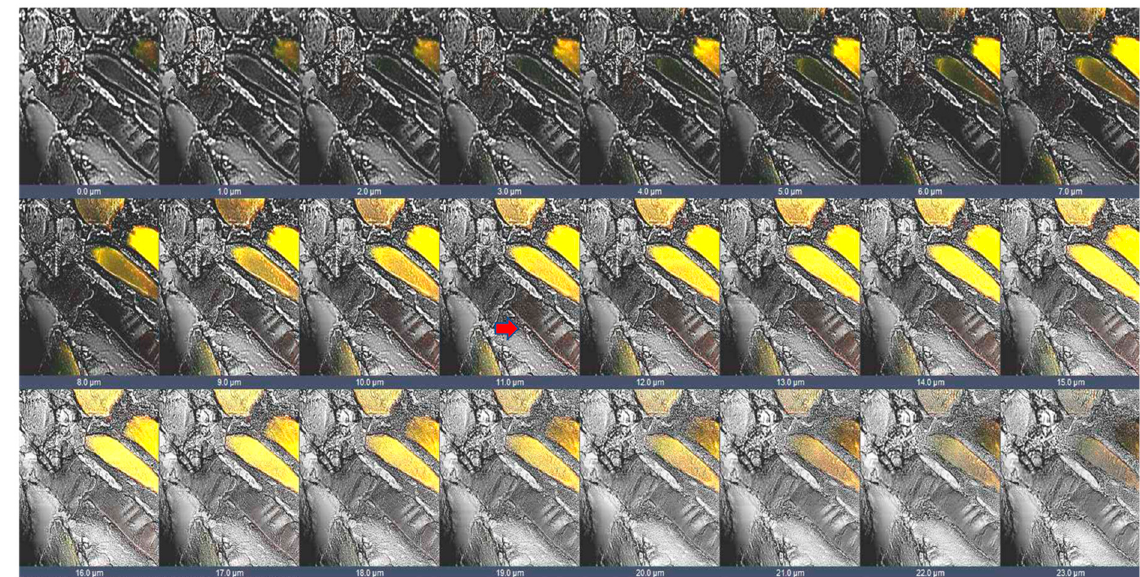
Figure 6. Gallery with 24 pictures of 1 µ m thickness each obtained by z-stack function of confocal laser microscope. The figure shows double immunofluorescence reaction between alpha- and beta- dystroglycan (yellow fluorescence) in sternocleidomastoid muscle of low-ranking baboons. This 3D reconstruction confirms the presence of negative fibers for both alpha-SG and beta-dystroglycan along the thickness of section, as evidenced by transmitted light (red arrow). The same data have been found for all the SG isoforms.